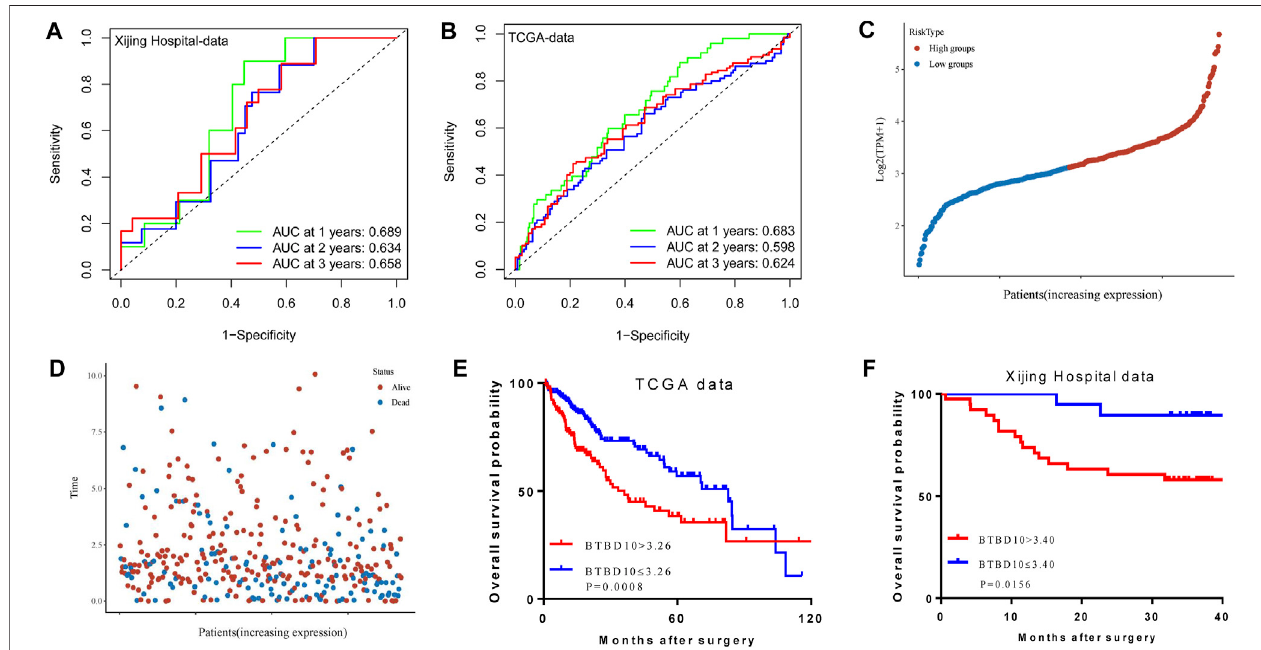
FIGURE3| ThepredictiveabilityoftheBTBD10for1,2,and3 years: (A) ROCcurvesdrawnusingTCGAdata; (B) ROCcurvesdrawnusingXijingHospitaldata.In the TCGA data, the expression of BTBD10 was related to the survival time and survival status of patients: (C) risk curves; (D) survival status distribution map. Kaplan-Meier curve in patients with hepatocellular carcinoma: (E) TCGA data; (F) Xijing Hospital data.